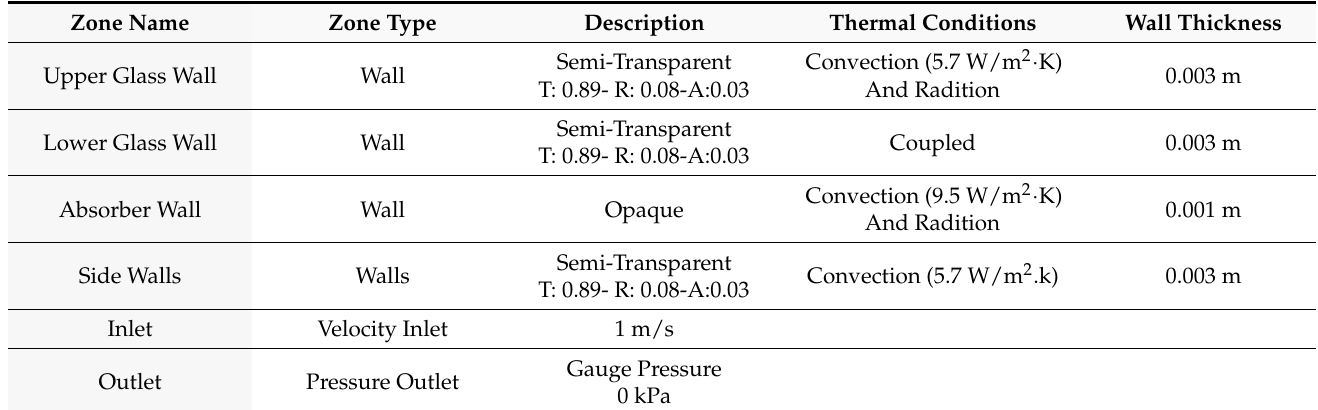
Table 1. Boundary types and conditions for FPSAHs models.